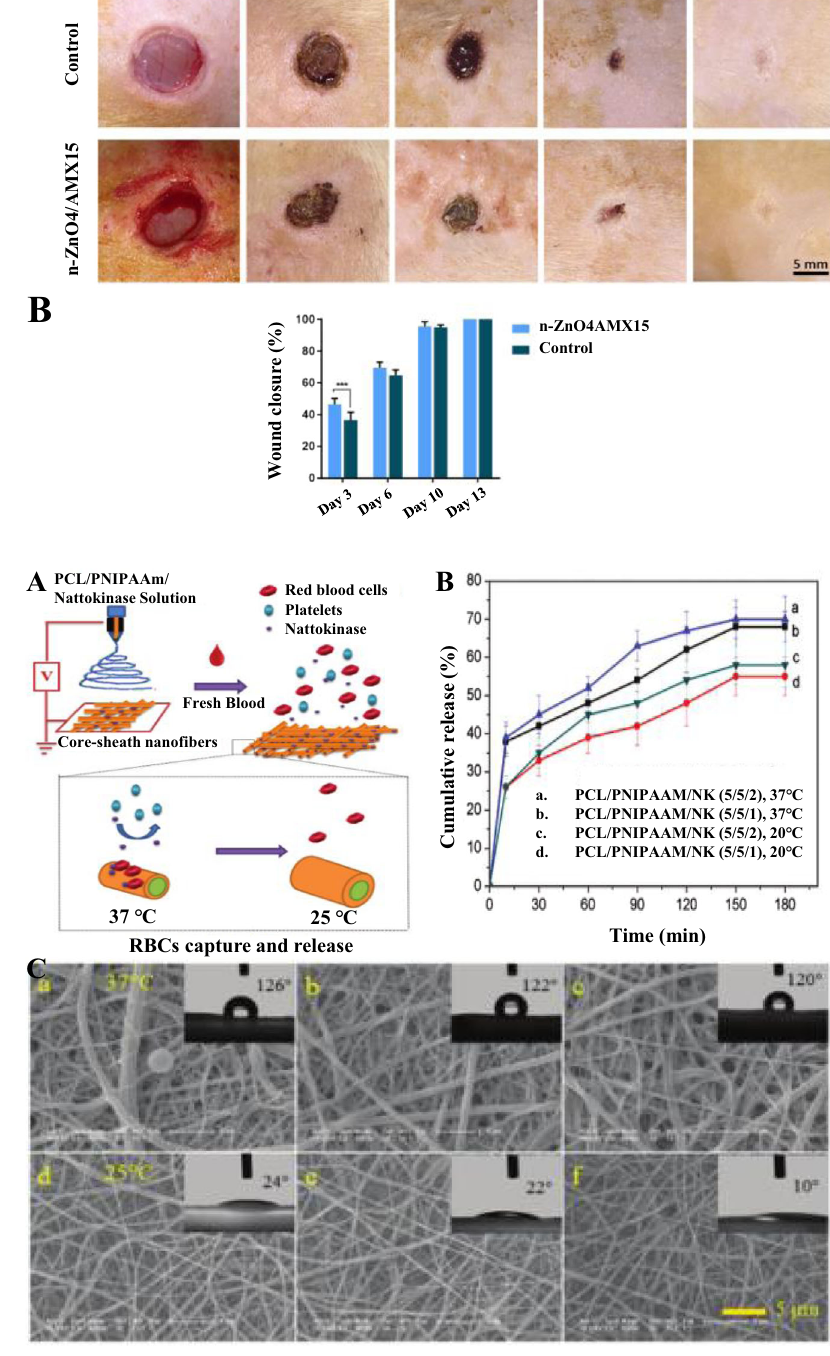
Fig. 8 Optical images (scale bar = 5 mm) and wound shrinkage images of the wound site at different times in the control and experimental groups (*** p < 0.001) [131]